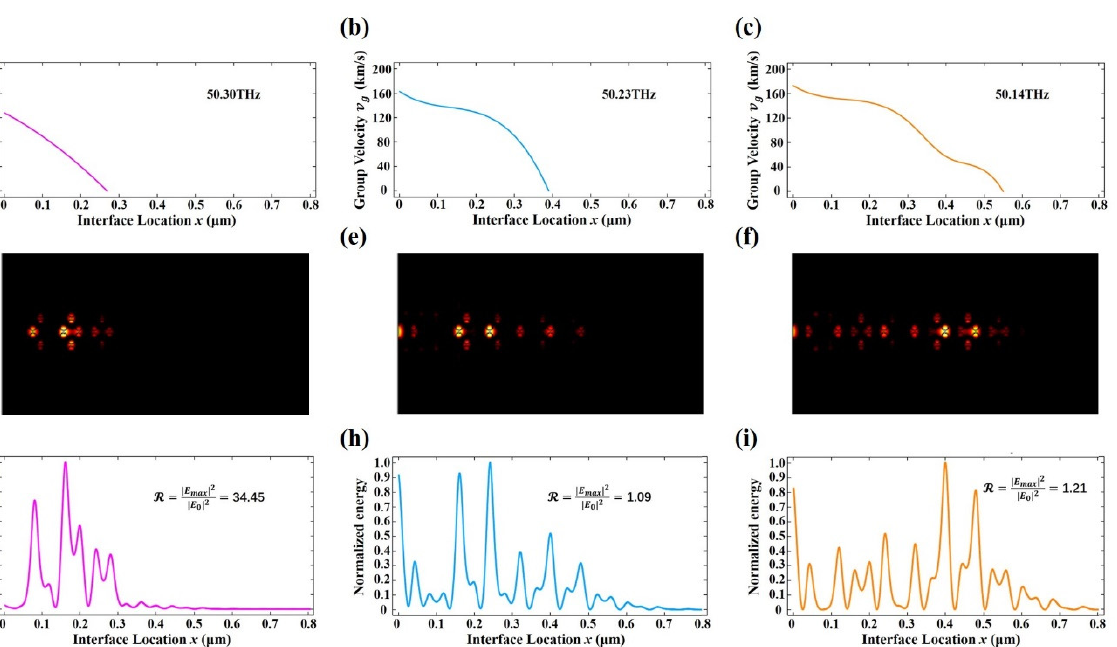
Figure 5. Variations of group velocities and light field of the edge SPP waves along with the interface of the chirped VGPM waveguide. ( a – c ) Calculated group velocities as a function of the interface location x at frequencies of 50.30, 50.23, and 50.14 THz. ( d – f ) Numerically experimental photonic light field fields of the edge SPP waves in the chirped VGPM waveguide at frequencies of 50.30, 50.23, and 50.14 THz. ( g – i ) Normalized edge SPP wave light field distributions corresponding to the simulated results along with the interface of the chirped VGPM waveguide. The intensity enhancement factors R = | E max | 2 / | E 0 | 2 were 34.45, 1.09, and 1.21,